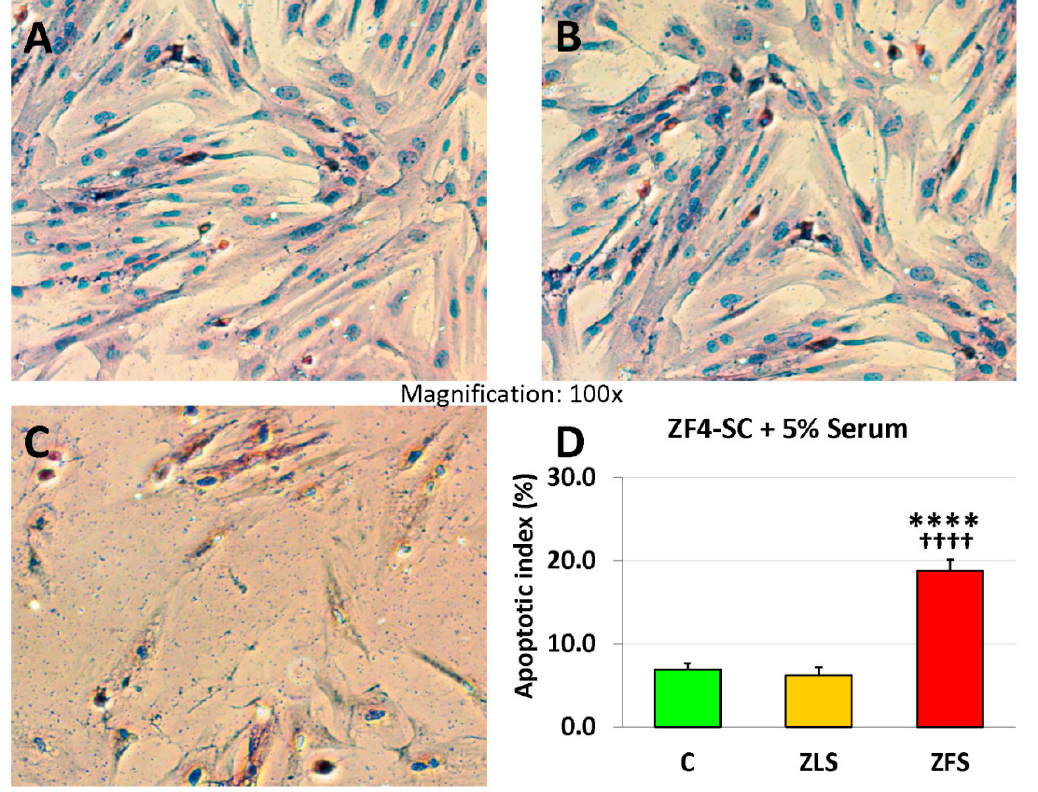
Figure 3. Incubation of ZF4-SC with ZFS-induced apoptosis, but the one caused by ZLS was negligible, similar to when no rat serum was added. ZF4-SC were incubated with no addition ( A ), or added ZLS ( B ), or ZFS ( C ), as in Figure 1, then subjected to the TUNEL reaction, and pictures were taken at 100X. The bar graph in ( D ) is equivalent to the one in Figure 1D, but on a linear scale with **** p ≤ 0.0001 (C vs. ZFS); ++++ p ≤ 0.0001 (ZFS vs. ZLS).